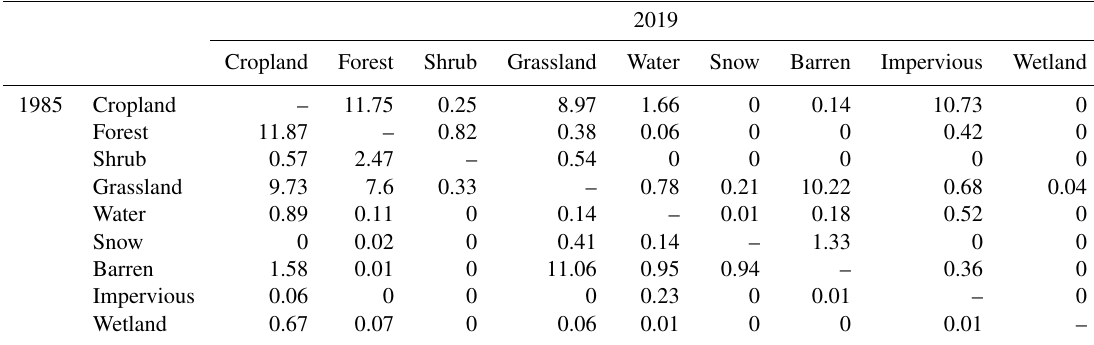
Table 4. Ratio (%) of land cover conversions from 1985 to